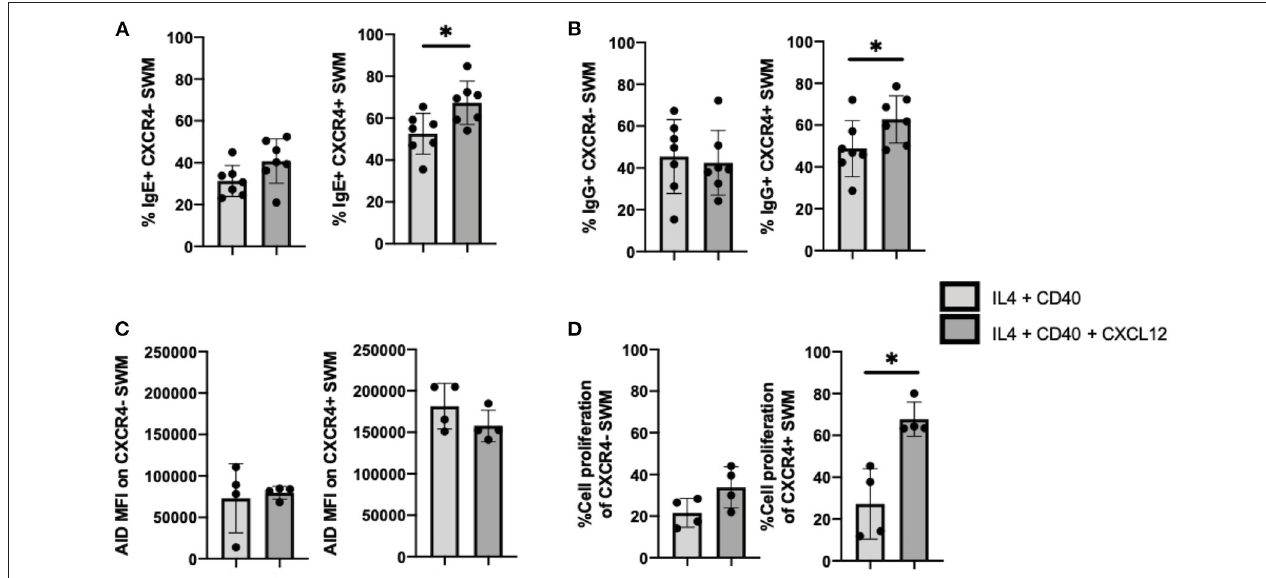
FIGURE 6 | CXCL12/CXCR4 intrinsic signaling drives proliferation of SWM B cells. (A) Percentage of IgE + of CXCR4- SWM and CXCR4 + SWM after 10 days culture with 20ng/mL IL-4, 10 ug/mL anti-CD40 ± 100ng/mL CXCL12. (B) Percentage of IgG + of CXCR4- SWM and CXCR4 + SWM after 10 days culture with 20ng/mL IL-4, 10 ug/mL anti-CD40 ± 100ng/mL CXCL12. (C) Expression of AID measured by MFI on CXCR4- SWM and CXCR4 + SWM after 3 days culture with 20ng/mL IL-4, 10 ug/mL anti-CD40 ± 100ng/mL CXCL12. (D) Percentage of cell proliferation measured by cell-trace violet of CXCR4- SWM and CXCR4 + SWM after 3 days